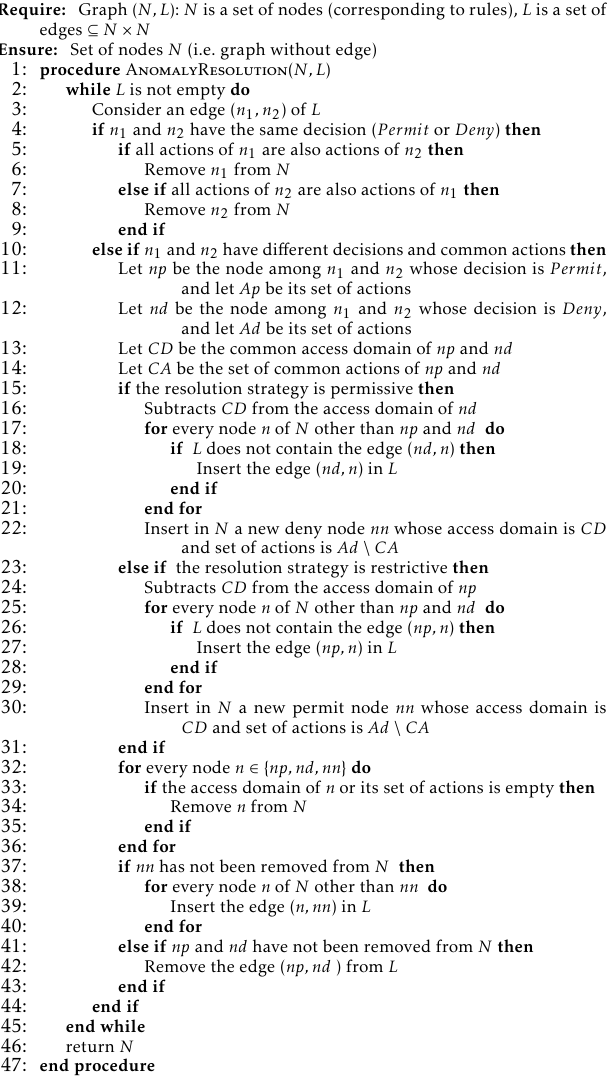
Algorithm 1 Anomaly Detection and Resolution